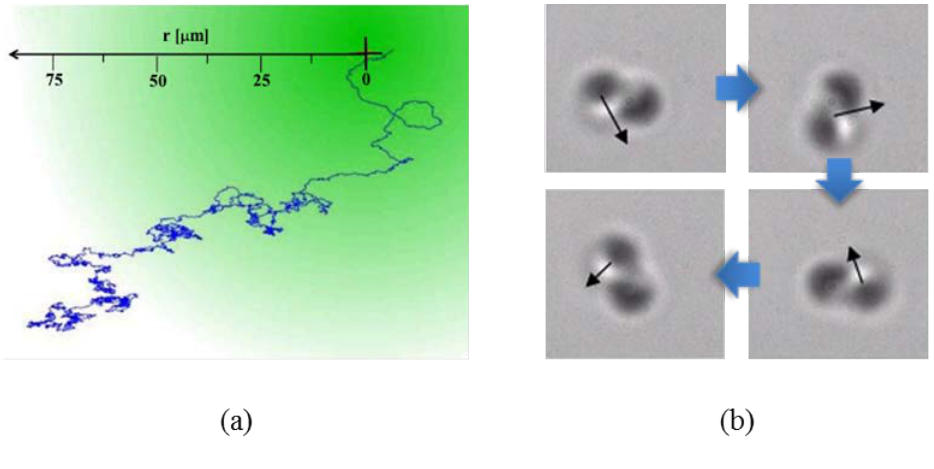
Figure 7. ( a ) Trajectory of a self-propelled Janus particle by light gradient [35]; ( b ) rotational motion of a twin Janus particles by self-thermophoresis in defocused laser beam (time interval is 0.2 s)